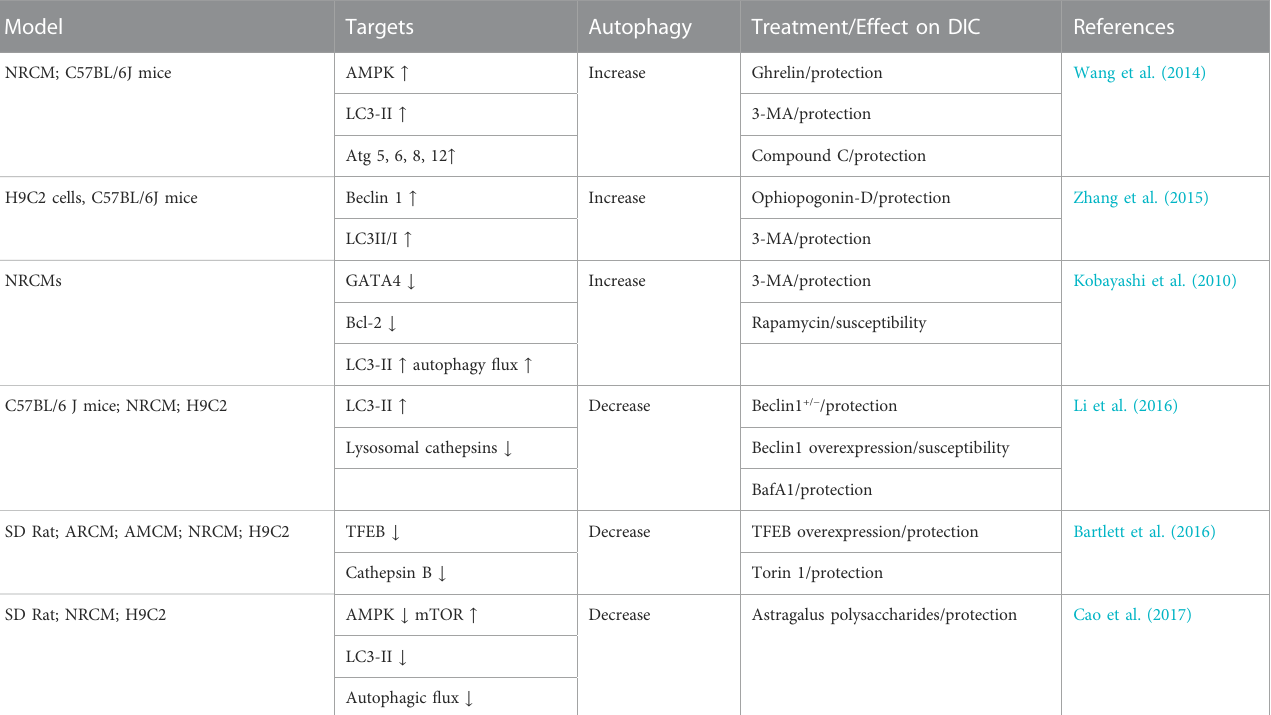
TABLE 1 Evidence of doxorubicin-induced autophagy in the